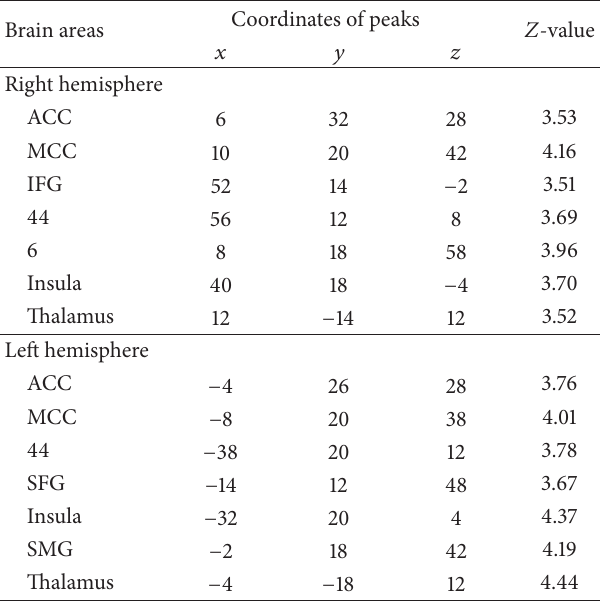
Table 2: Brain regions where activity was related to the occurrence of movement errors (ERROR image).